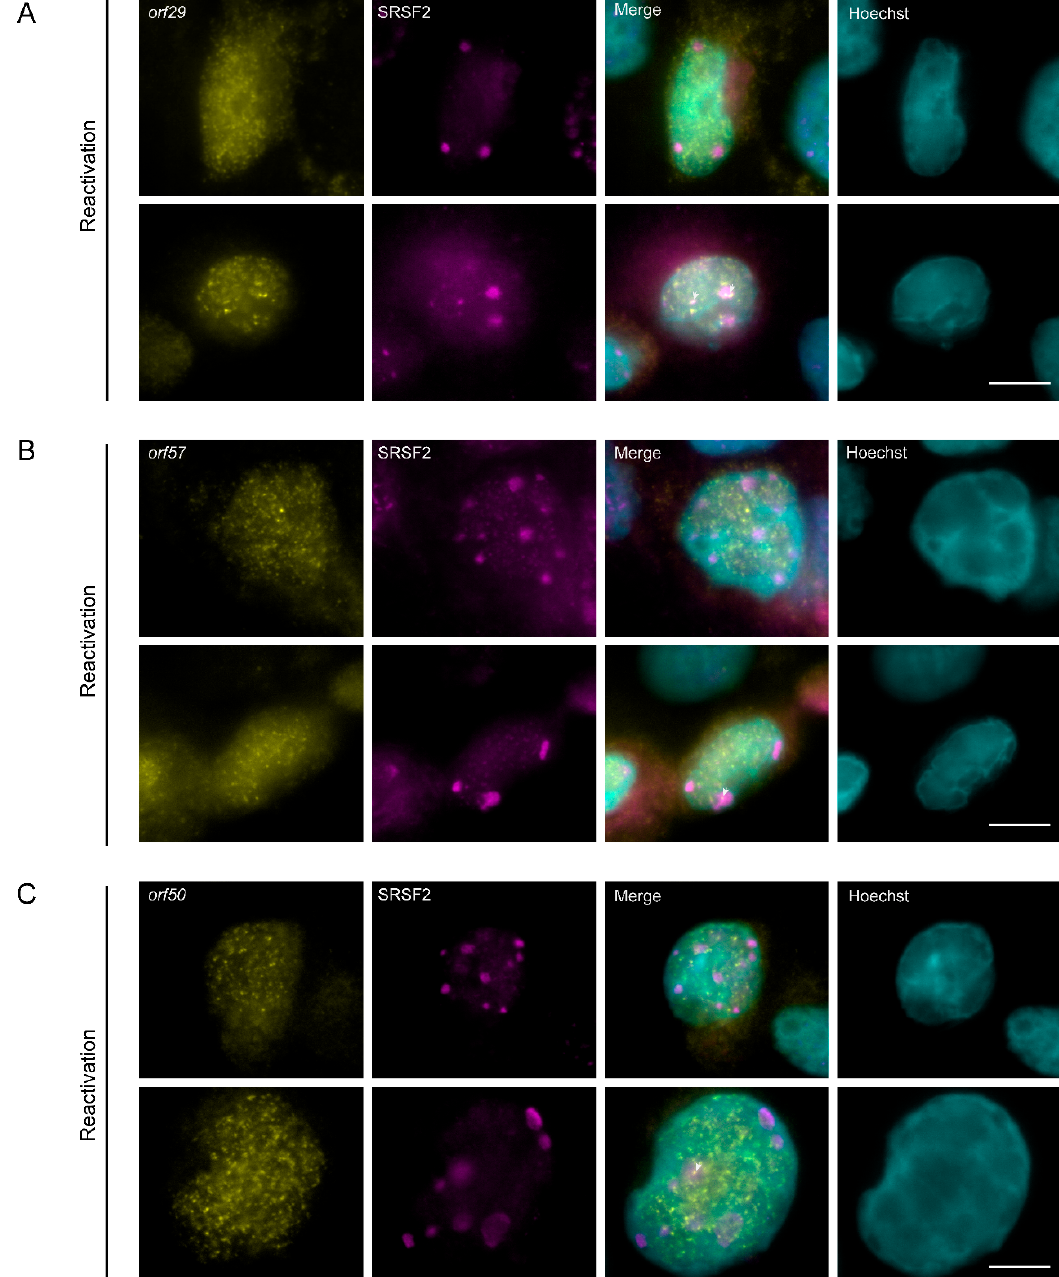
Figure 9. The distribution of spliced viral mRNAs during lytic reactivation of KSHV infection. ( A ) orf29 and ( B ) orf57 mRNAs were detected by RNA FISH (yellow) in BAC16 infected iSLK cells that were treated to induce the lytic cycle of KSHV infection for 48 h. ( C ) orf50 (yellow) sites of transcription detected by RNA FISH to the intron of orf50 pre-mRNA. SRSF2 in magenta; Hoechst in cyan. Arrowheads point to nuclear speckles that have viral RNA signal within them. Bar, 10 μ m.